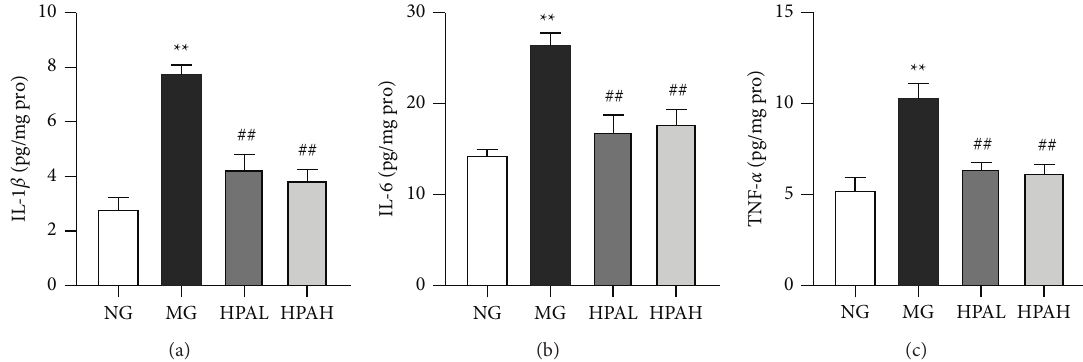
Figure 4: Effect of HPA on inflammation response in ALD mice. (a) Hepatic IL-1 β ; (b) hepatic IL-6; (c) hepatic TNG- α . Data were expressed as mean ± SD ( n � 12). ∗∗ p < 0 . 01, versus NG; # p < 0 . 05 and ## p < 0 . 01, versus